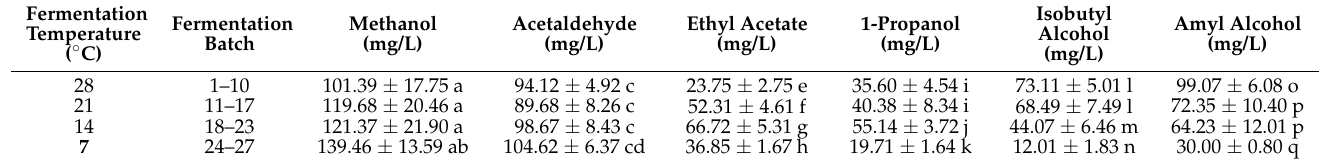
Table 3. Major volatile by-products of must repeated fermentation batches (12.5 ◦ Be) using immobi- lized biocatalyst at 28, 21, 14 and 7 ◦ C.